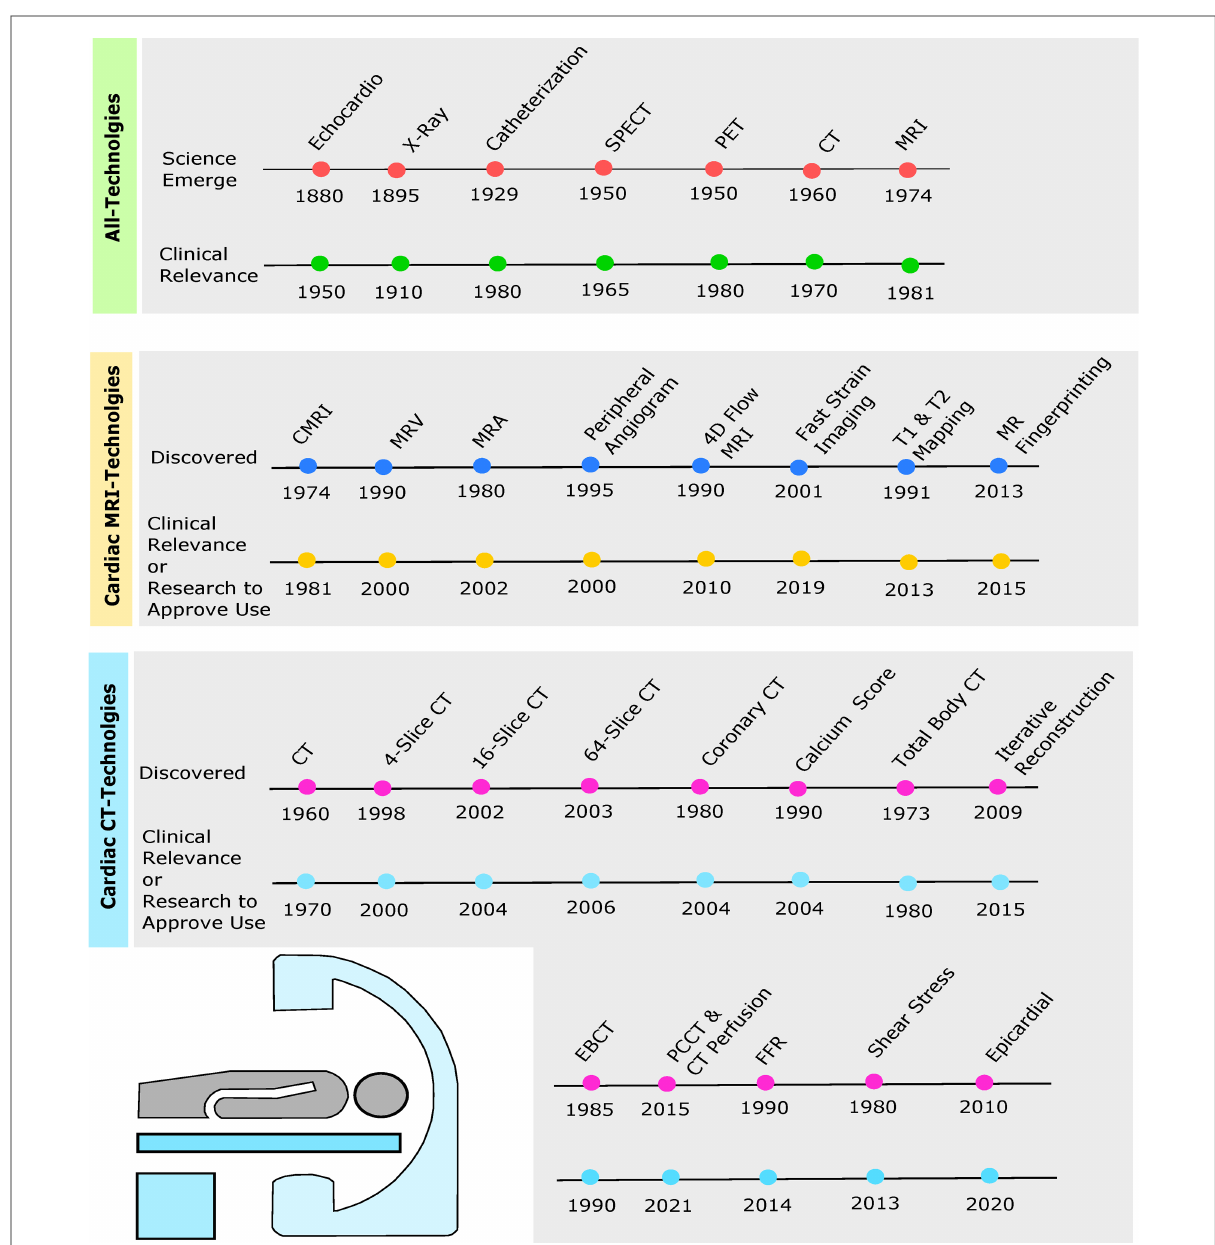
FIGURE 1 Timelines depict originating year of cardiac imaging invention followed by the year of clinical relevance or enough evidence from research to be approved by the Food and Drug Administration (FDA) for clinical use. Green timeline includes echocardiogram, chest x-ray, cardiac catheterization, SPECT, PET, cardiac CT, and cardiac MRI. Yellow timeline depicts cardiac MRI, magnetic resonance venography (MRV), magnetic resonance angiography (MRA), peripheral MRA, 4D fl ow, fast strain-encoded (fast-SENC) cardiac imaging, T1 and T2 mapping, and cardiac magnetic resonance (MR) fi ngerprinting (MRF). Blue timeline shows cardiac CT, 4-slice CT, 16-slice CT, 64-slice CT, coronary CT, calcium score, total body CT, iterative reconstruction (IR), electron beam CT (EBCT), photon-counting CT (PCCT), fractional fl ow reserve (FFR), wall shear stress (WSS), and epicardial fat enhancement